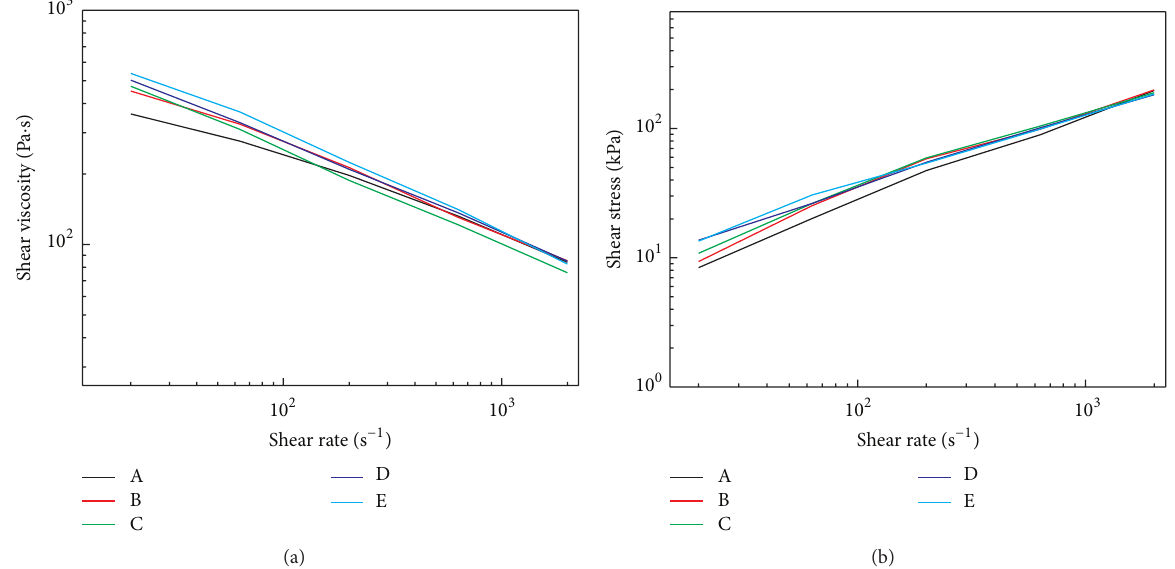
Figure 7: The shear rates-shear viscosity and shear rates-shear stress curves of blends (A: PC/PLA = 70/30; B: PC/PLA/TPU = 70/30/10; C: PC/PLA/TPU = 70/30/20; D: PC/PLA/TPU = 70/30/30; E: PC/PLA/TPU/DBTO =